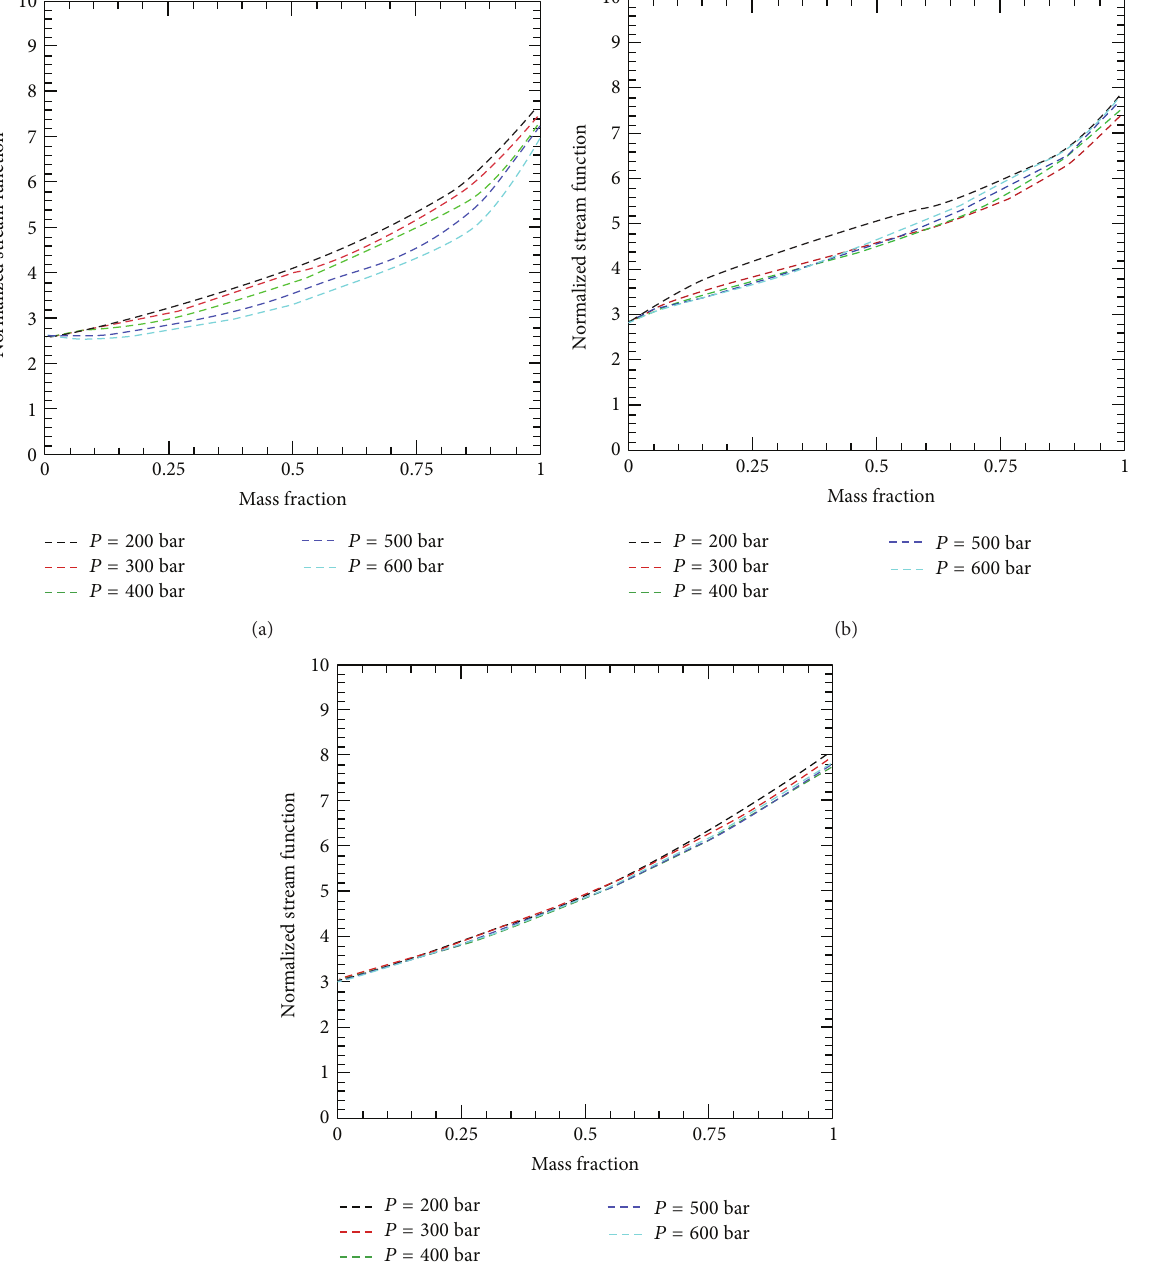
= 516 K; 𝑇 = 431 ℎ 𝑐